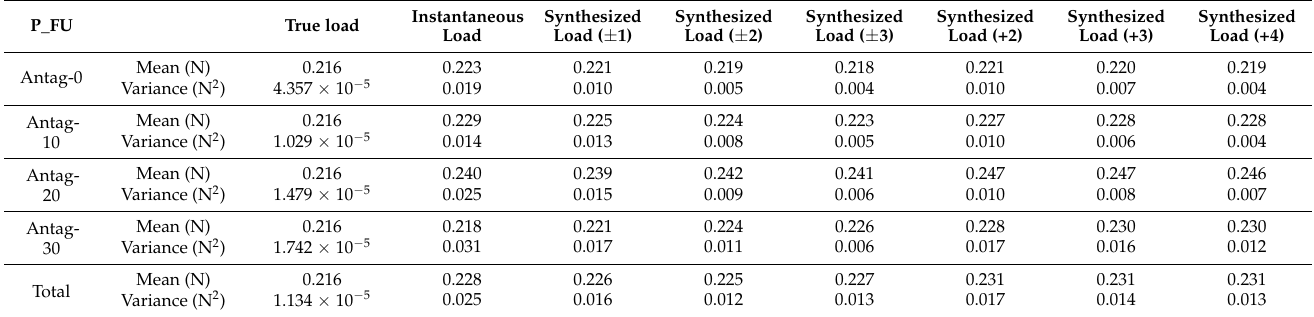
Table 2. The mean and variance of different exploration sequences with true load 0.22